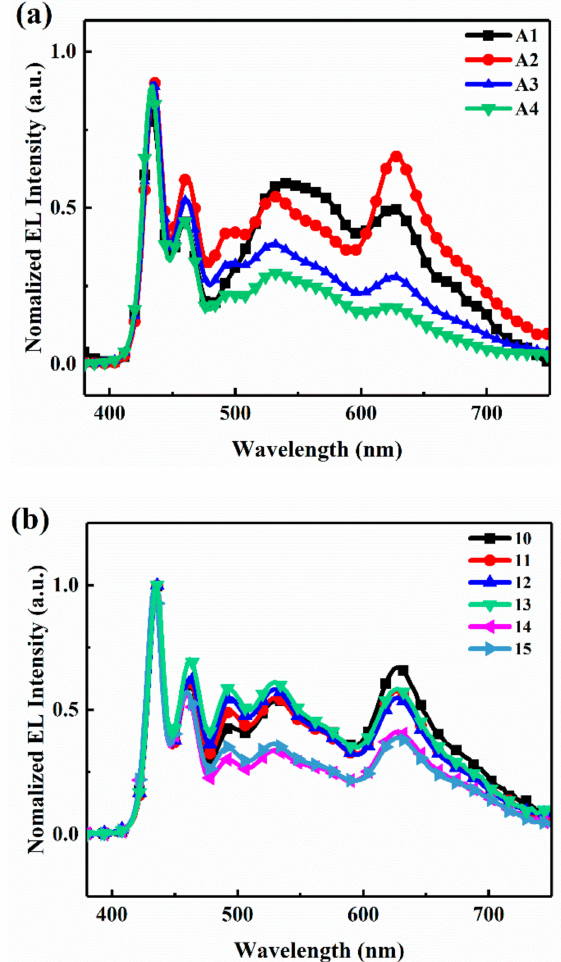
Figure 4. The spectral behaviors. ( a ) The normalized electroluminescence (EL) spectra of device A1–A4 at a driving voltage of 10 V, ( b ) the normalized EL spectra of device A2 at different